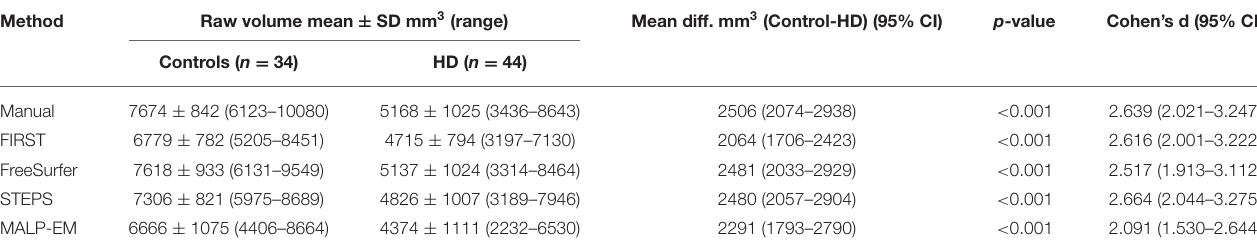
TABLE 2 | Raw caudate volume and effect sizes (Cohen’s d) for all techniques (manual and automated tools). Method